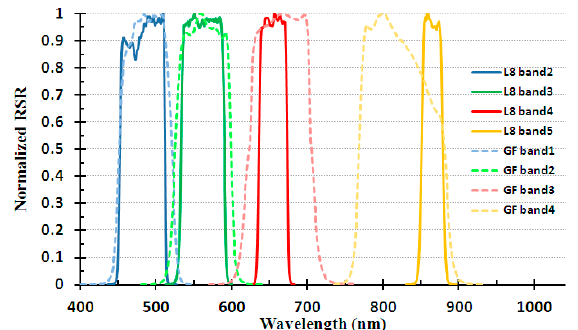
Figure 2. Comparison of the RSR (Relative Spectral Response) profiles between Gaofen-1 WFV3 and Landsat-8 OLI .